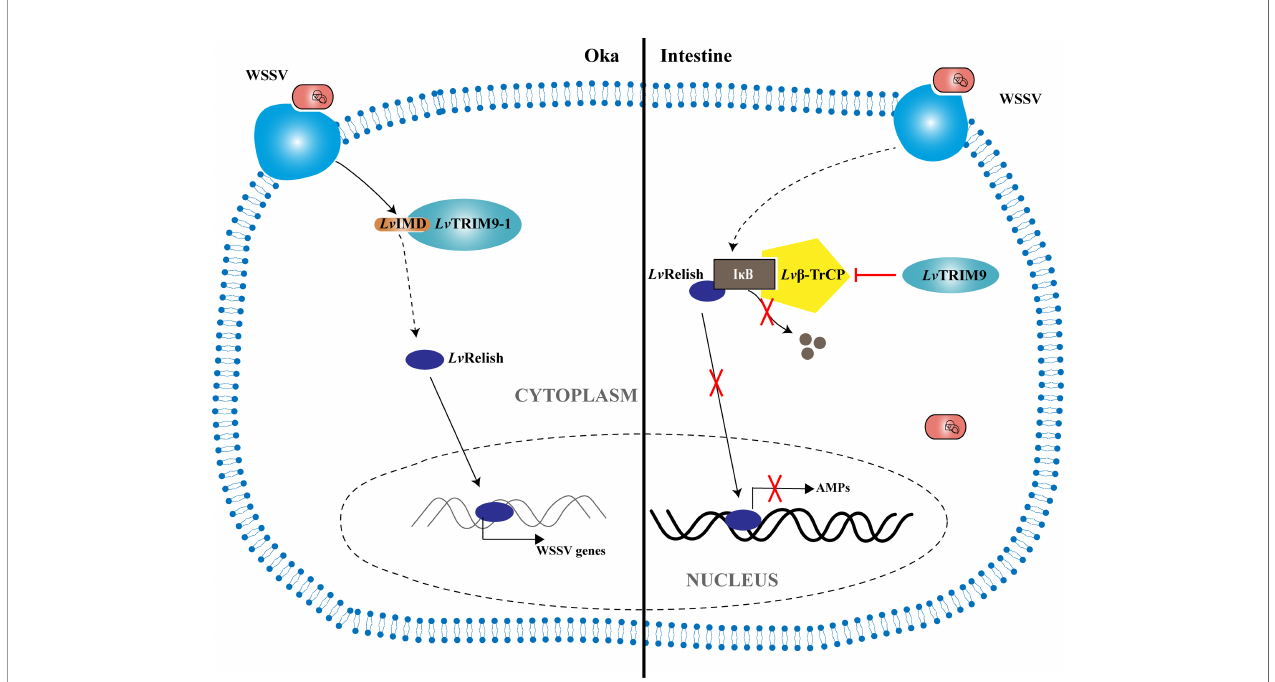
FIGURE 5 | Model for the regulation of NF- k B signalingpathway duringWSSV infection byLvTRIM9and LvTRIM9-1. In the intestine, infection of host cells byWSSV leads to the activation of LvTRIM9, then the upregulated LvTRIM9 interacts with Lv b -TrCP andinhibits theNF- k B pathway to decrease the production of downstream antimicrobial peptides including LvCrustinA, LvPEN3-1, Lvpenaeidin2b,and Lvpenaeidin4a, which results in WSSV propagation inshrimp. Although WSSV infection also results in the upregulation ofLvTRIM9-1, LvTRIM9-1 modulates the NF- k B pathway-mediatedresponses ina different manner. Instead of interaction with Lv b -TrCP, LvTRIM9-1 interacts with LvIMD via its SPRYdomain and activates the NF- k B pathway,which leadsto the activation of viraltranscriptionsincluding wsv069 and wsv303 for